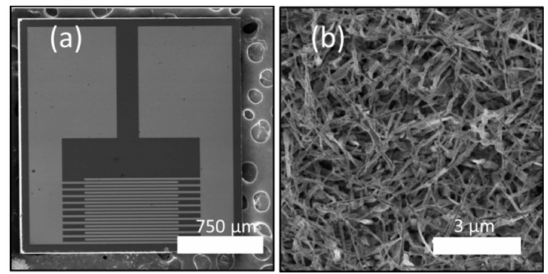
Figure 5. SEM images (top view) of ( a ) the gas sensing device and ( b ) network of the ZnO nanowires covering the sensor surface. Taken and adapted from [39] with permission from The Royal Society of Chemistry,